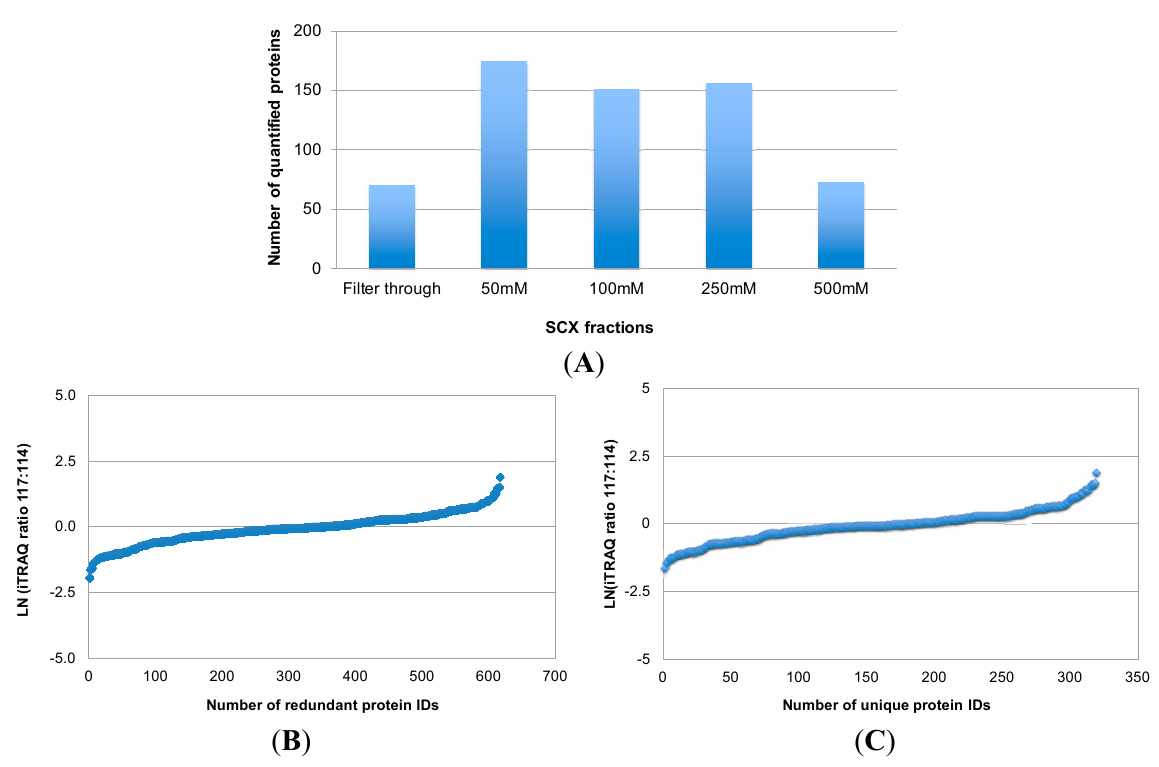
Figure 2. Quantitative proteomic analysis of serum proteins from OSCC patients with Approach 1. In Approach 1, both OSCC and control protein samples were digested in solution, and the resulting peptides were labeled with iTRAQ tags, respectively. Afterwards, the labeled peptides were combined and fractionated with SCX at four different salt concentrations (50, 100, 250, and 500 mM sodium chloride). The filter-through and four SCX fractions were then analyzed by reversed phase LC with MS/MS. The number of proteins quantified in each SCX fractions is shown in ( A ); and their relative levels between OSCC and healthy control subjects are presented in ( B ); The total number of unique proteins quantified by this approach and their relative levels between OSCC and healthy control subjects are shown in ( C